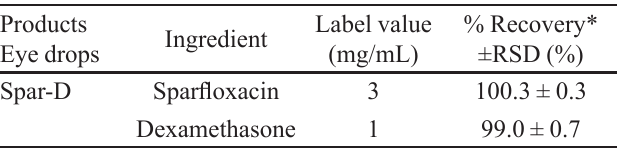
TABLE VI - Assay results of sparfloxacin and dexamethasone